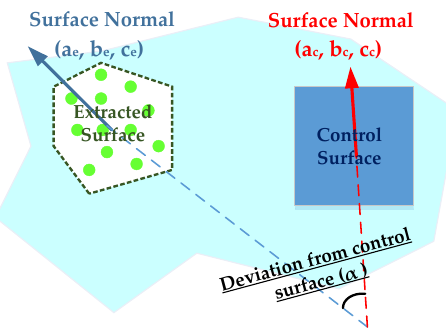
Figure 33. Quality control of an extracted planar surface with respect to its corresponding control planar surface.